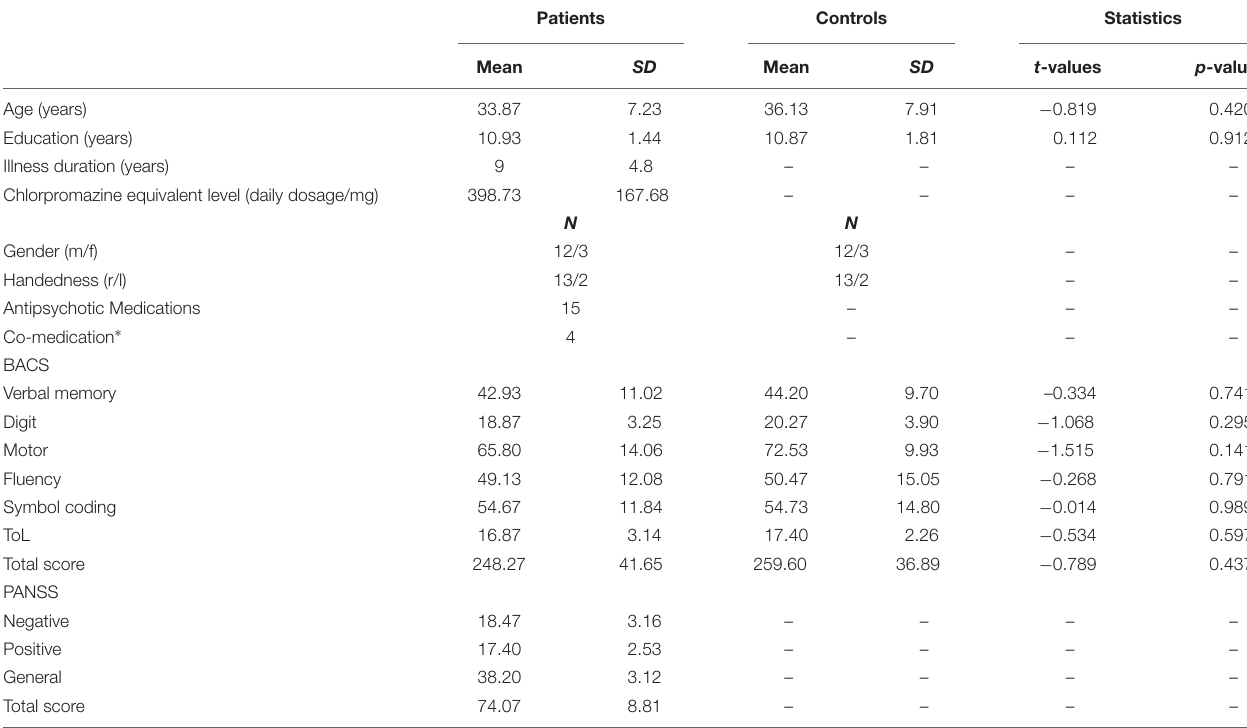
TABLE 1 | Demographic data, positive and negative syndromes, and cognitive scores in the study